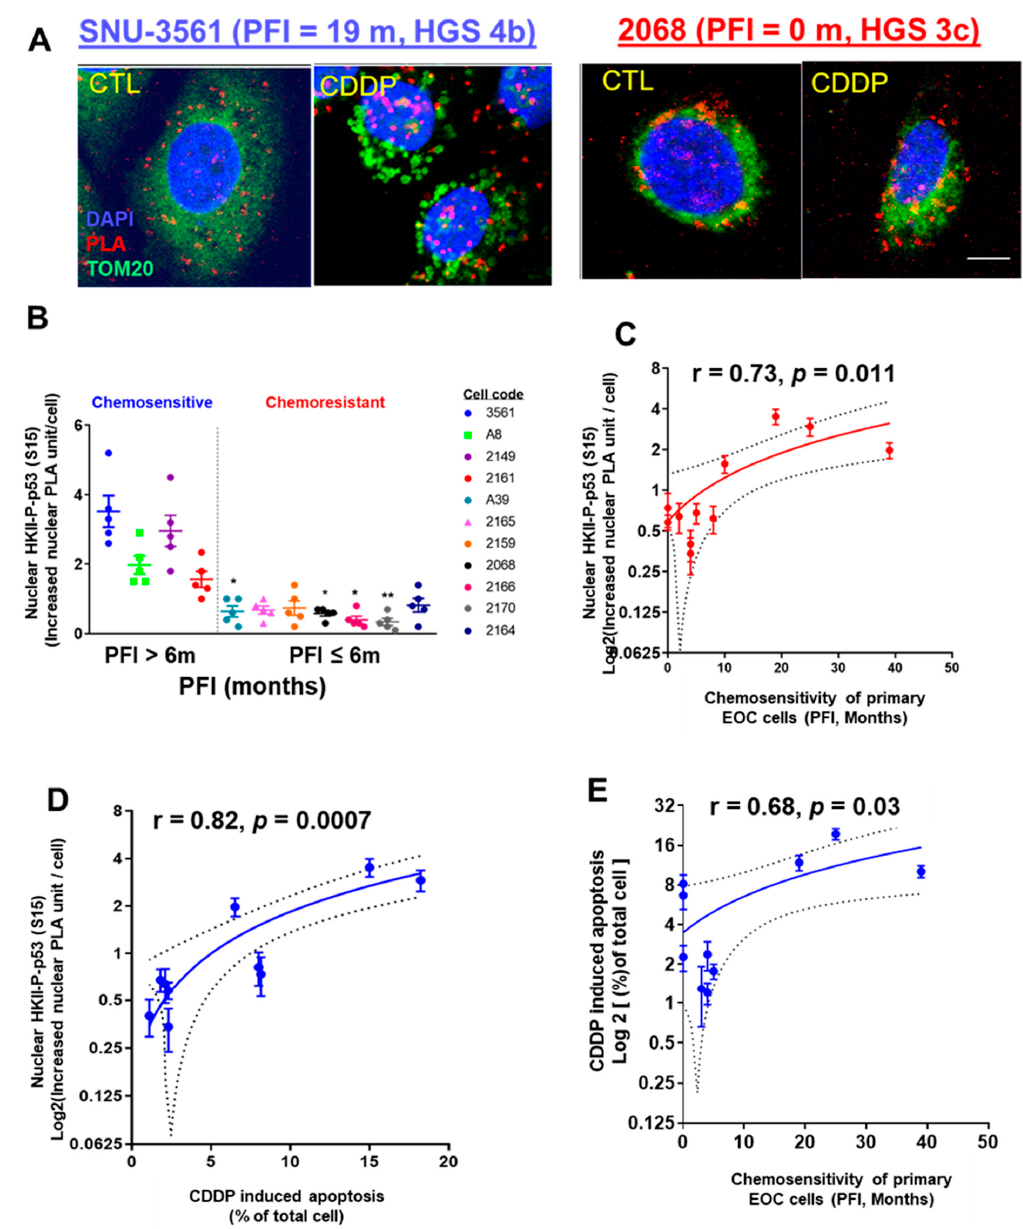
Figure 2. CDDP promotes interaction and intracellular trafficking of HKII-P-p53 (Ser15) to the nuclei of chemosensitive primary human OVCA cells. ( A ) Primary human EOC cell lines were established from chemosensitive SNU 3561 (PFI = 20 m) and chemoresistant 2068 (PFI = 0 m) cancers, and treated in culture with CDDP (10 μ M, 24 h), or with DMSO as a vehicle control. Interaction of HKII and P-p53 (Ser15) (red dot) was measured via PLA. Cells were counterstained with anti-TOM20 (green) and DAPI (blue) before analysis with a Duolink Image Tool; scale bar: 10 μ m. ( B ) Left panel: Eleven primary human EOC cell lines established from chemosensitive (PFI > 6 months, n = 4) or chemoresistant (PFI ≤ 6 m, n = 7) cancers were treated and analyzed as in ( A ) for a PLA interaction between nuclear HKII and P-p53 (Ser15). ( C ) Right panel: Correlation between the CDDP-driven increase in nuclear PLA units for the interaction of HKII and P-p53 (Ser15), and PFI. ( D ) Correlation between the CDDP-driven increase in nuclear PLA units for the interaction of HKII and P-p53 (Ser15), and CDDP-induced apoptosis measured by Hoechst staining, to judge chemosensitivity in cell culture. ( E ) Correlation between the CDDP-driven increase in nuclear PLA units for the interaction of HKII and P-p53 (Ser15), and PFI, to judge chemosensitivity in primary ovarian cancer cells. Error bars denote ± SEM ( n = 5). Results are expressed as mean ± SEM ( n = 5) (* p < 0.05, ** p < 0.01, CTL vs. CDDP). The correlations were analyzed using Pearson’s correlation (r)